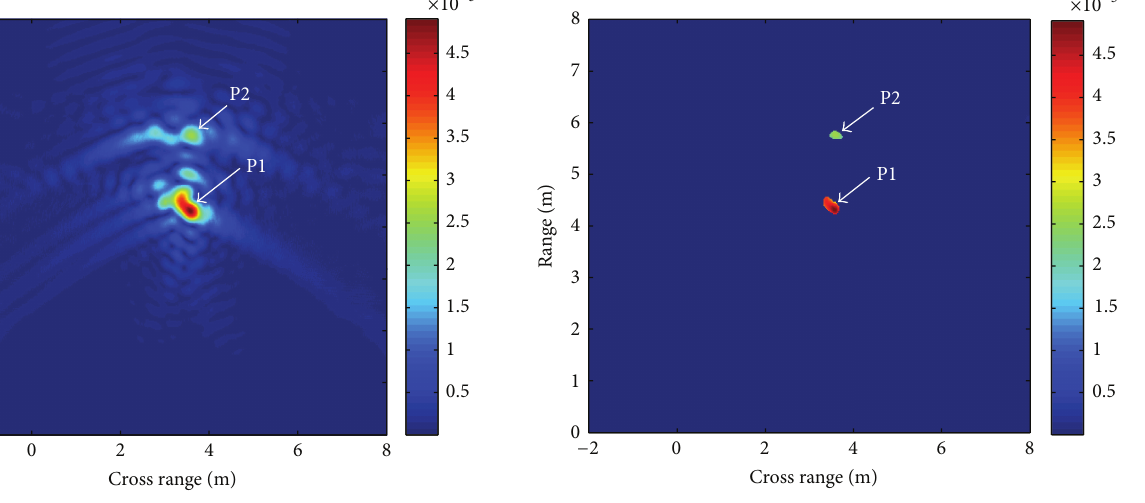
Figure 19: The true target and the ghost have been detected in the image after CFAR processing.